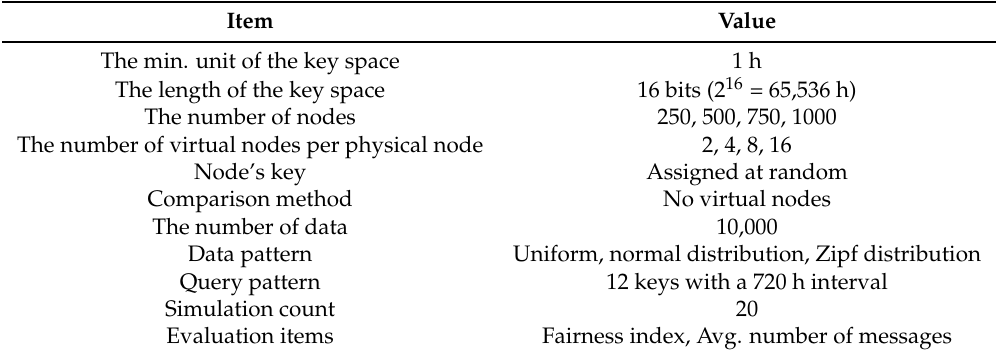
Table 2. Simulation environment.